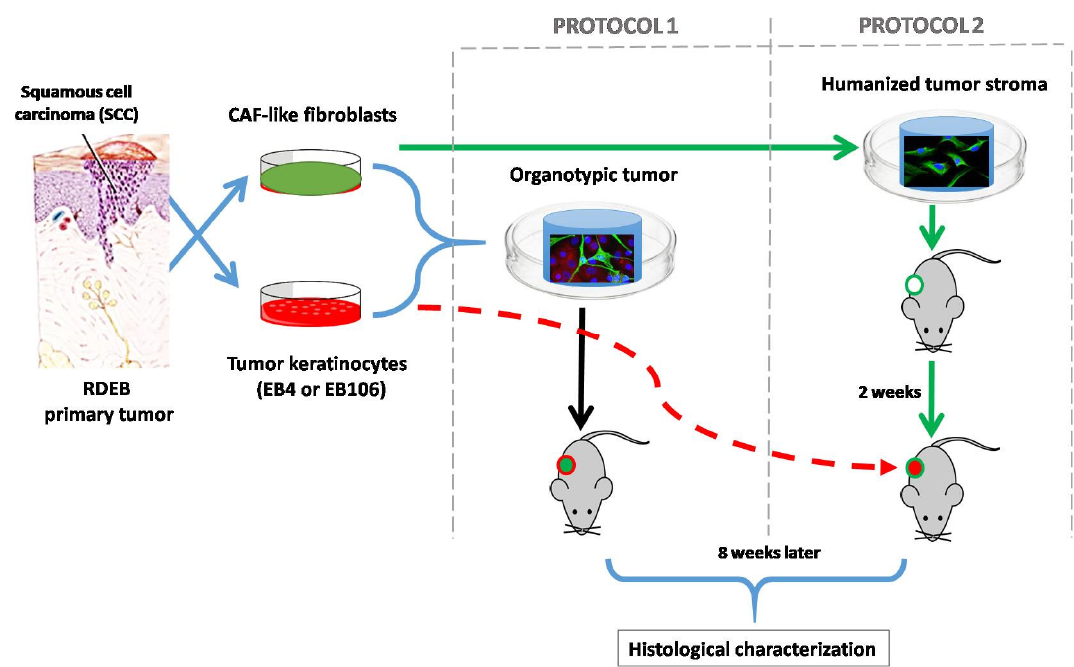
Figure 1. Tissue engineering humanized stroma for development of squamous cell carcinomas (SCC) in immunodeficient mice: two di ff erent approaches were followed. In protocol 1 simultaneous injection of tumoral cells and stroma (cancer associated fibroblasts (CAF)-like cells and biocompatible matrix) was performed, whereas in protocol 2 the generation of a humanized stroma was performed 2 weeks before the injection of the neoplastic keratinocytes. SCC-cells and stromal fibroblasts derived from recessive